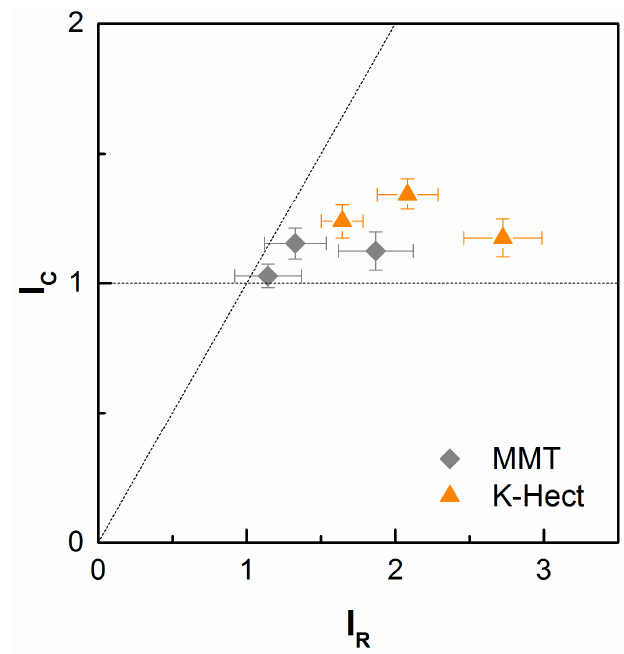
Figure 9. Comparison of improvement of fracture toughness by layered silicates in neat resin ( I R ) and composites ( I C ).